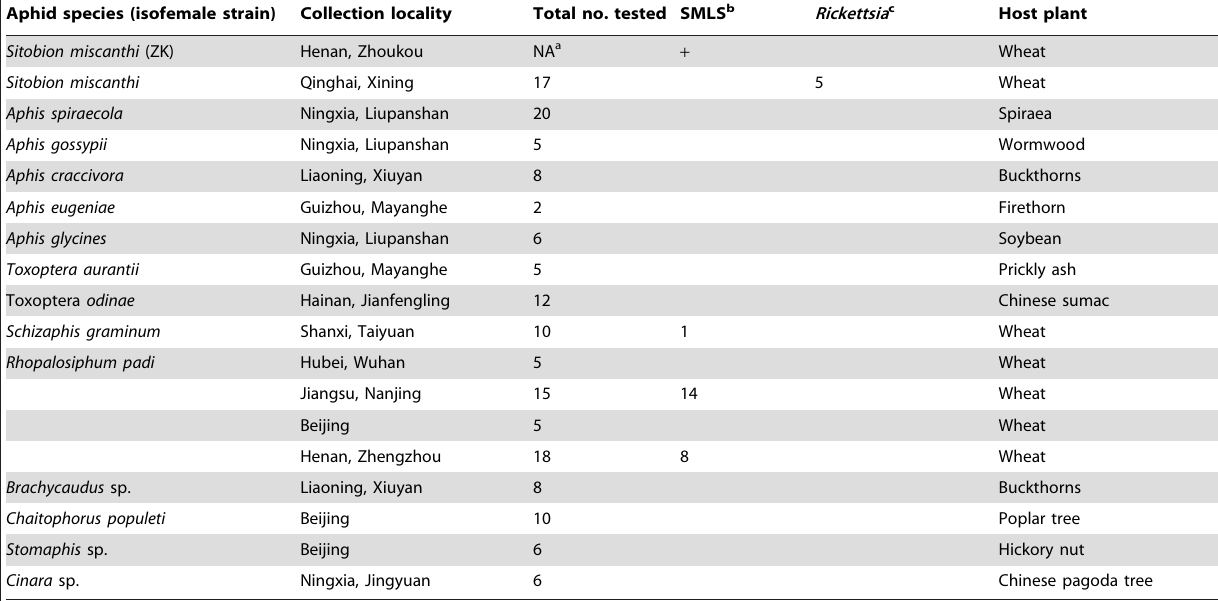
Table 1. Aphids examined in present